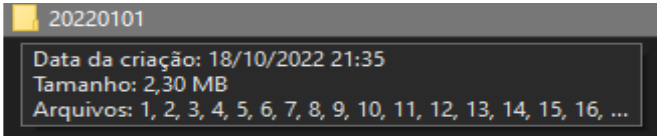
Figure 12: Size of a user's frame folder.